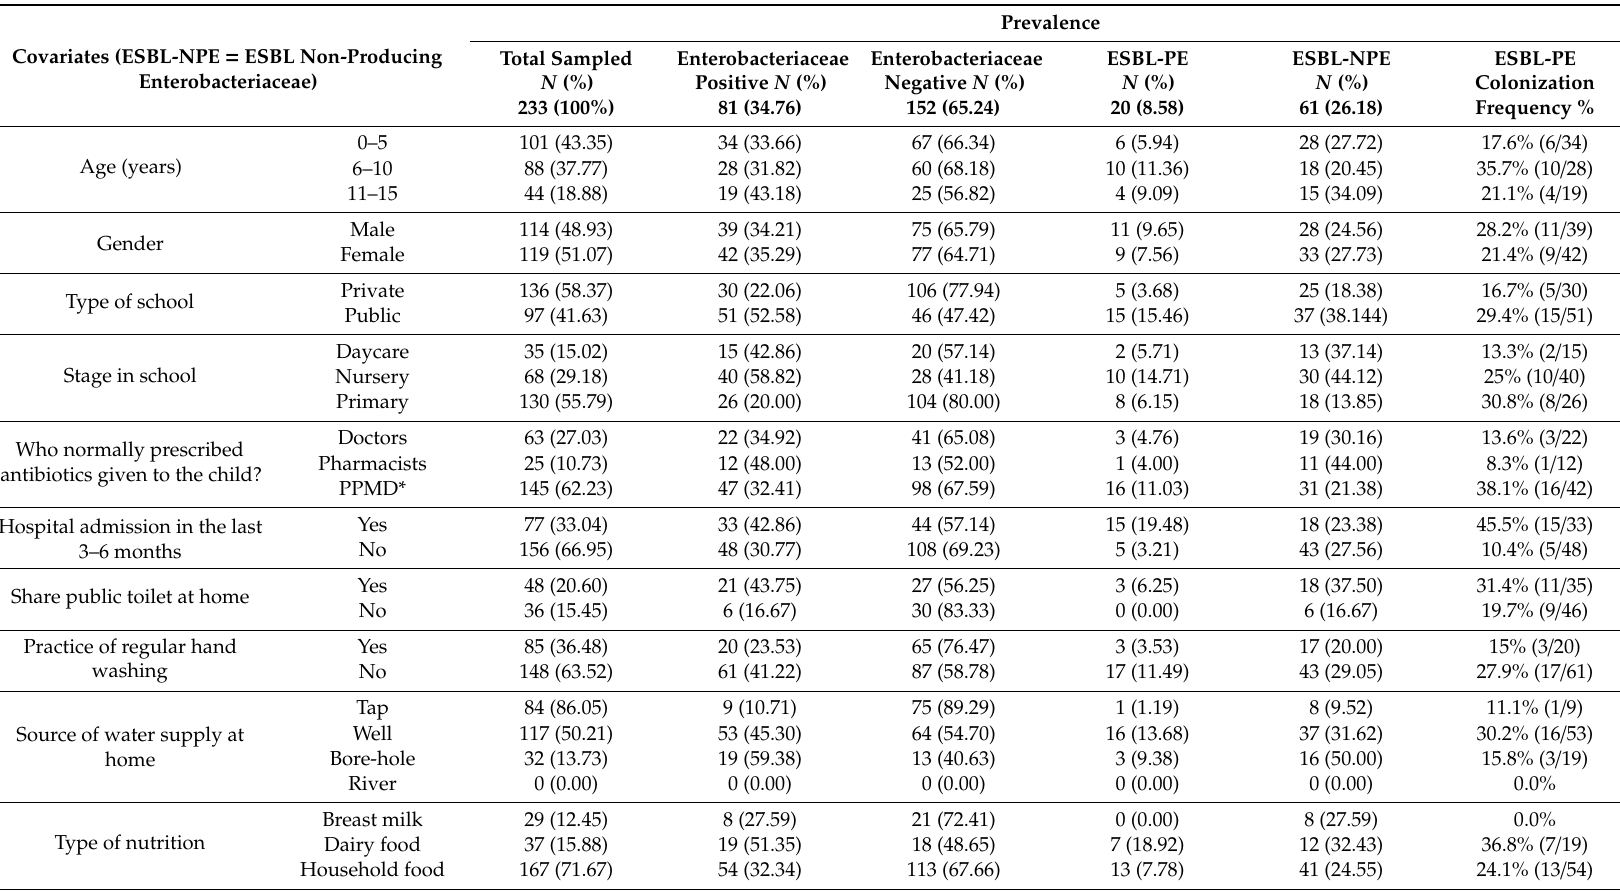
Table 3. Survey of risk factors associated with ESBL-producing Enterobacteriaceae (ESBL-PE) carriage in sick children in